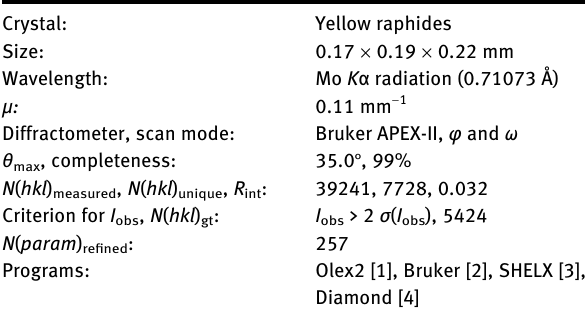
Table  : Data collection and